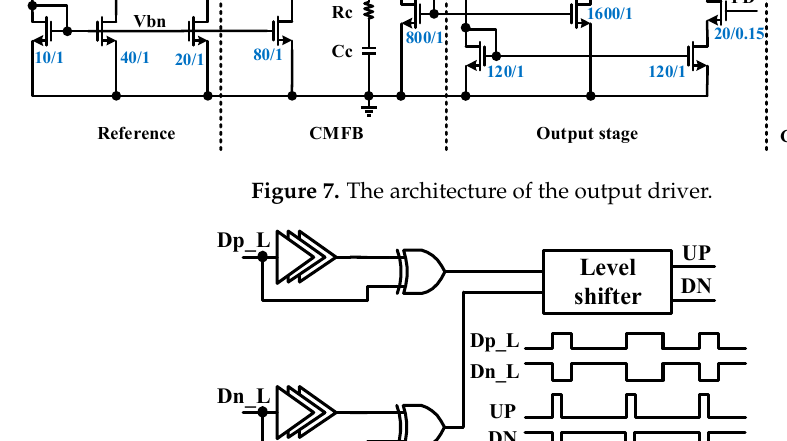
Figure 8. Simplified schematic of the pre-emphasis driver.